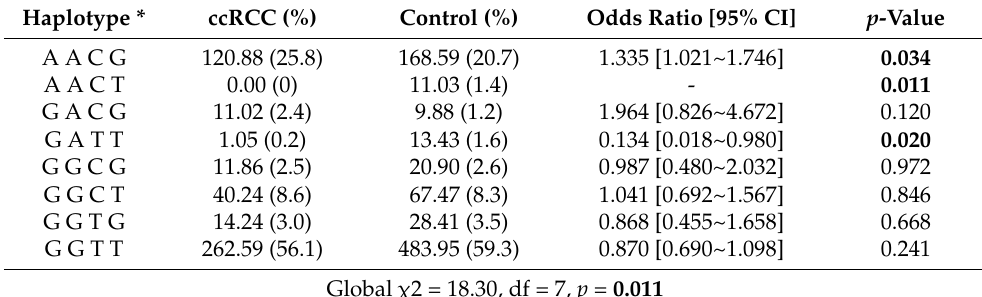
Table 4. Haplotype distribution of LGALS9 SNPs between ccRCC patients and controls. Haplotype